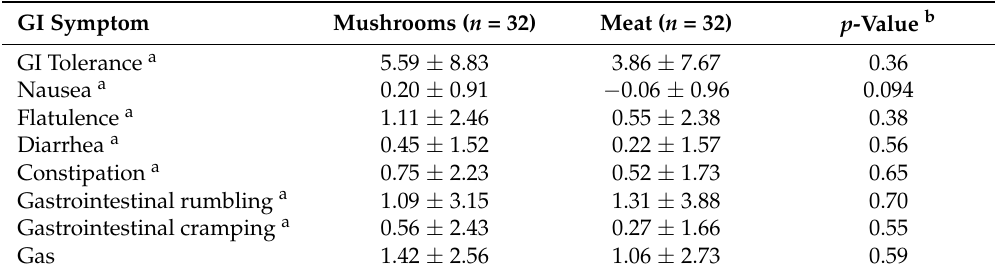
Table 6. Gastrointestinal tolerance measures day